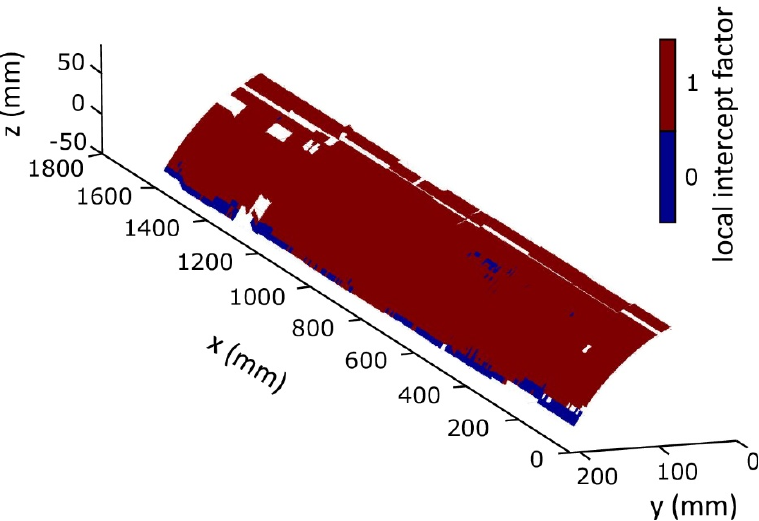
Figure 16. Map of the local intercept factor .